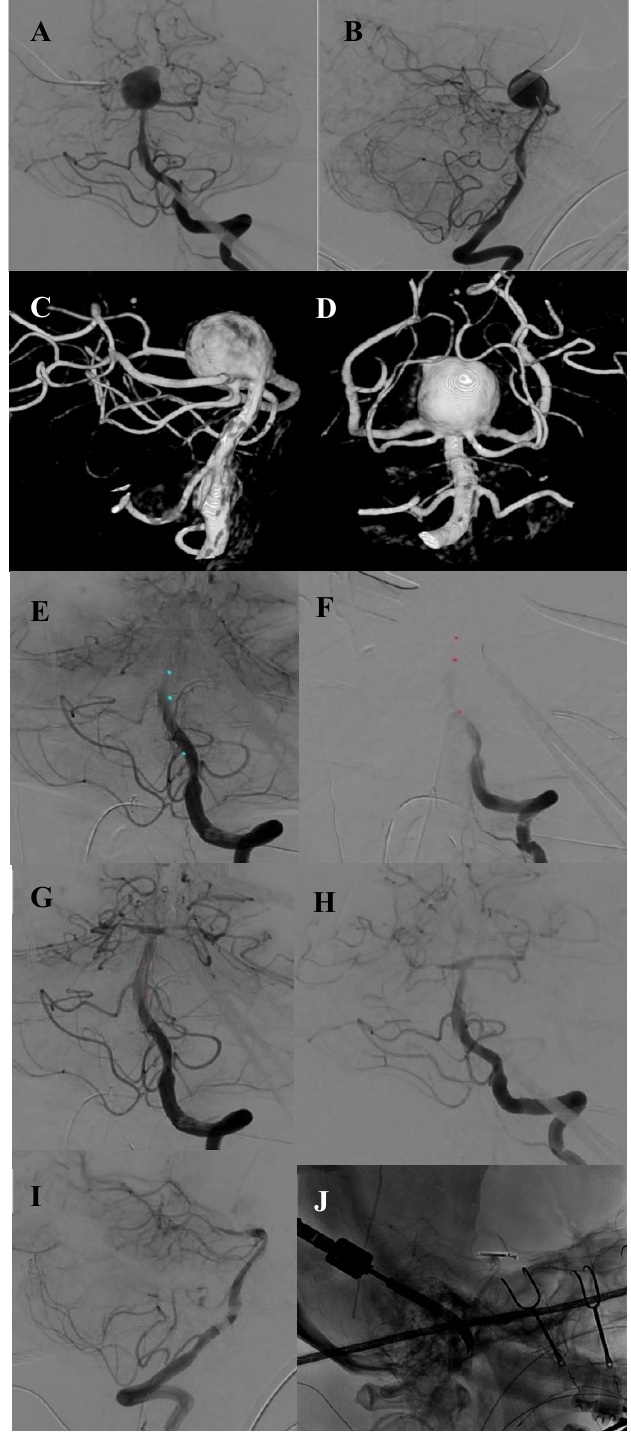
Figure 1. Case 1. Preoperative ap and lateral DSA of the basilar tip aneurysm ( A , B ). Preoperative 3D angiography of the basilar aneurysm presenting the bilateral origin of the PCA and SCA from the aneurysm base ( C , D ). Intraoperative angiography showing the endovascular placement of the balloon and occlusion of the basilar artery ( E , F ). Intraoperative DSA after clipping and closure of the balloon showing complete occlusion of the aneurysm in ap and lateral view with all branches open ( G – I ). Intraoperative picture of the opened skull, placed fish hooks, spatula and clip ( J ).